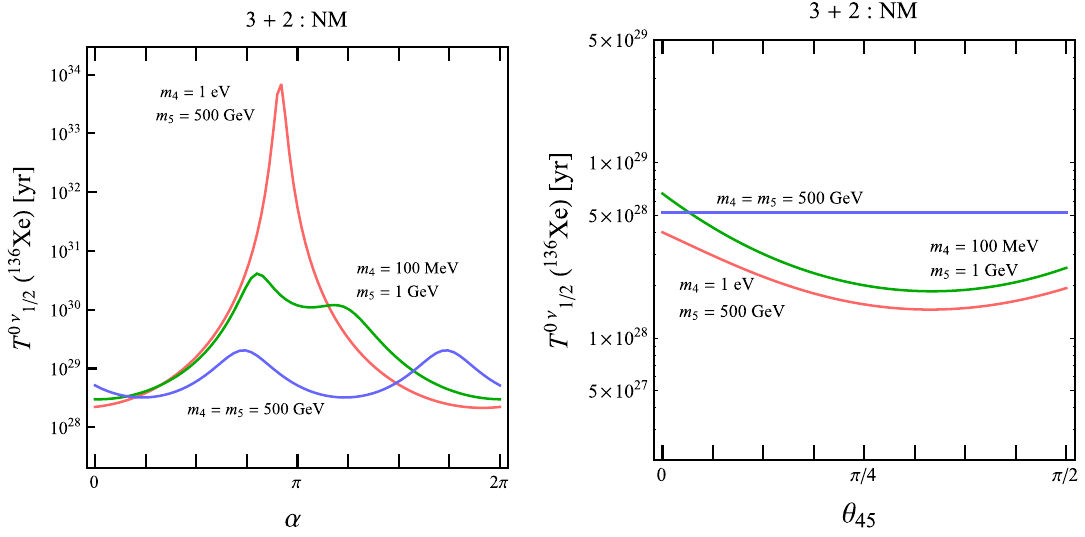
Figure 10 . Left panel: 0 (cid:23)(cid:12)(cid:12) decay half-life of 136 Xe in the NH as a function of the Majorana phase, (cid:11) , for m 4 ; 5 (cid:29) 1 GeV (blue), for m 4 = 1 eV and m 5 (cid:29) 1 GeV (red), and m 4 = 100 MeV and m 5 = 1 GeV. LECs and NMEs as in the left panel of (cid:12)gure 8. Right panel: similar but now for (cid:11) = 0 and we vary the mixing angle (cid:18) 45